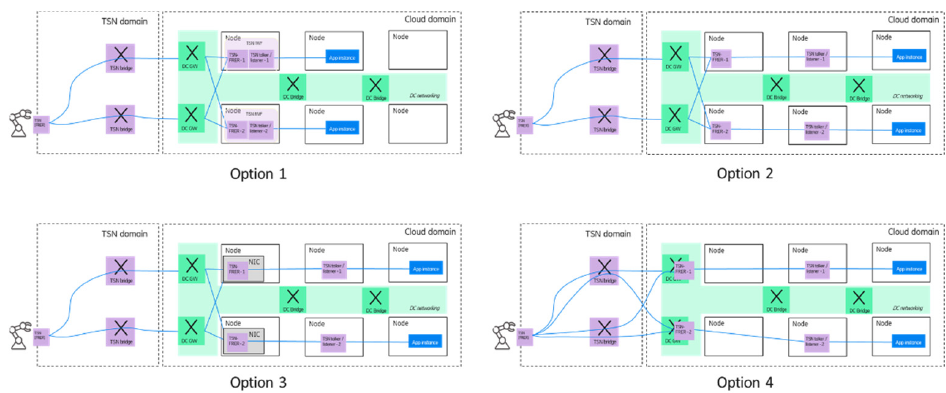
Figure 12. Deployment options for single, emulated application handling scenario.